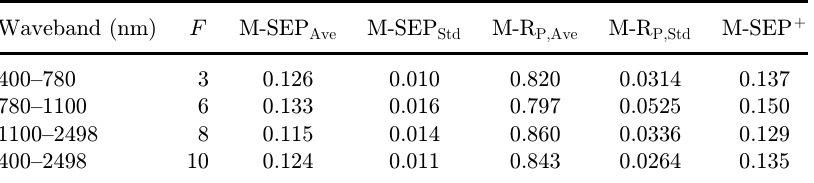
Table 1. Modeling prediction accuracy and stability of PLS models that correspond to the visible, short-NIR, long-NIR, and overall scanning